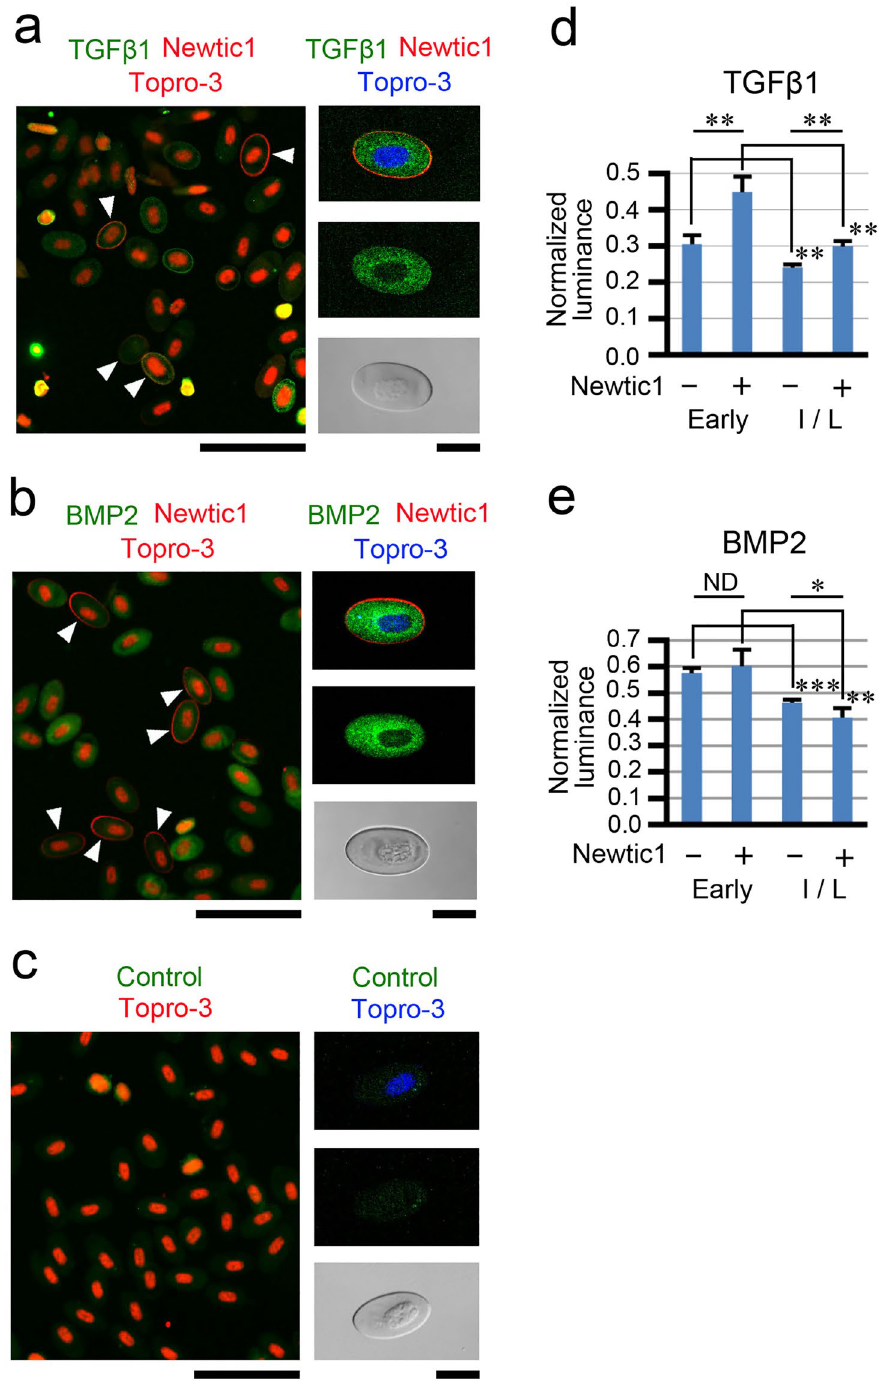
Figure 7. TGF β 1 and BMP2 are expressed in circulating erythrocytes. ( a ) Representative image showing TGF β 1 expression in PcNobs (n = 6). PcNobs in blood cell suspensions were double labeled with TGF β 1 (green) and Newtic1 (red) antibodies. Nuclei were also labeled with Topro-3 (red). Arrowheads point to Newtic1-positive (Newtic1 + ) PcNobs. PcNobs exhibited TGF β 1 immunoreactivity but their fluorescence intensity was variable. Note that the fluorescence intensity was sometimes higher along the equator of PcNobs, independent of the intensity of Newtic1 immunoreactivity. Scale bar, 100 μ m. Right hand column shows a particular Newtic1 + PcNob exhibiting intense TGF β 1 immunoreactivity in its cytoplasm. Upper two panels show confocal images. Scale bar, 20 μ m. ( b ) Representative image showing BMP2 expression in PcNobs (n = 3). PcNobs in blood cell suspensions were double labeled with BMP2 (green) and Newtic1 (red) antibodies. The data are presented in the same manner as in ( a ). PcNobs exhibited BMP2 immunoreactivity, but as in TGF β 1, their fluorescence intensity varied. ( c ) Control immunoreactivity (n = 3). PcNobs in blood cell suspensions were labeled with control (RFP; green) antibody. The data are presented in the same manner as in ( a